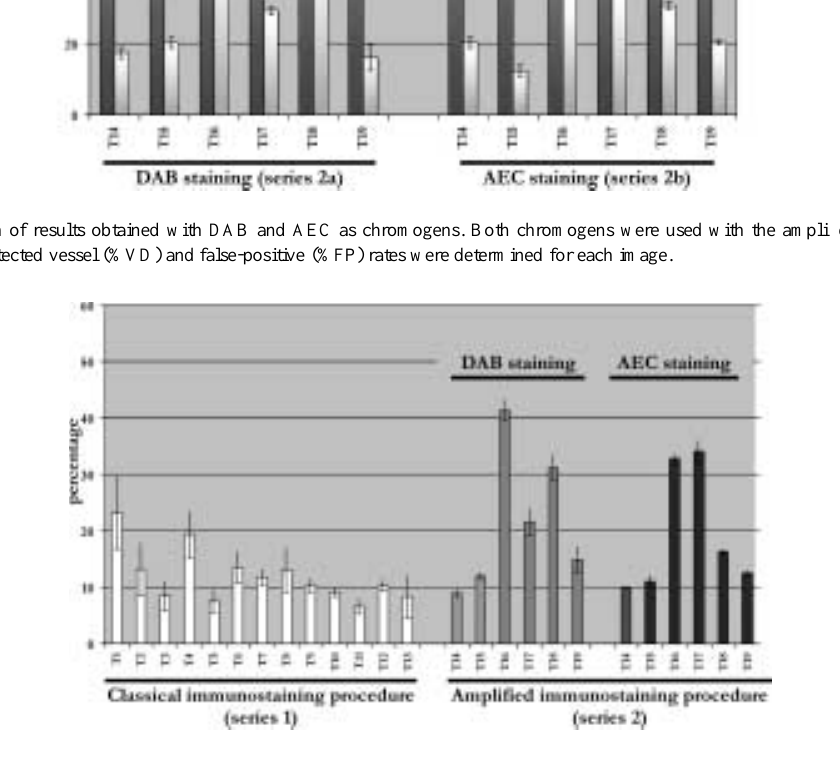
Fig. 8. Comparison of the relative surface proportion of false-positive vs. positive structures obtained after classical and enhanced immunostaining procedures. This relative surface proportion (rSP) was defined as a ratio: (surface proportion of false-positives / surface proportion of positives) × 100. rSP was determined for series 1 and series